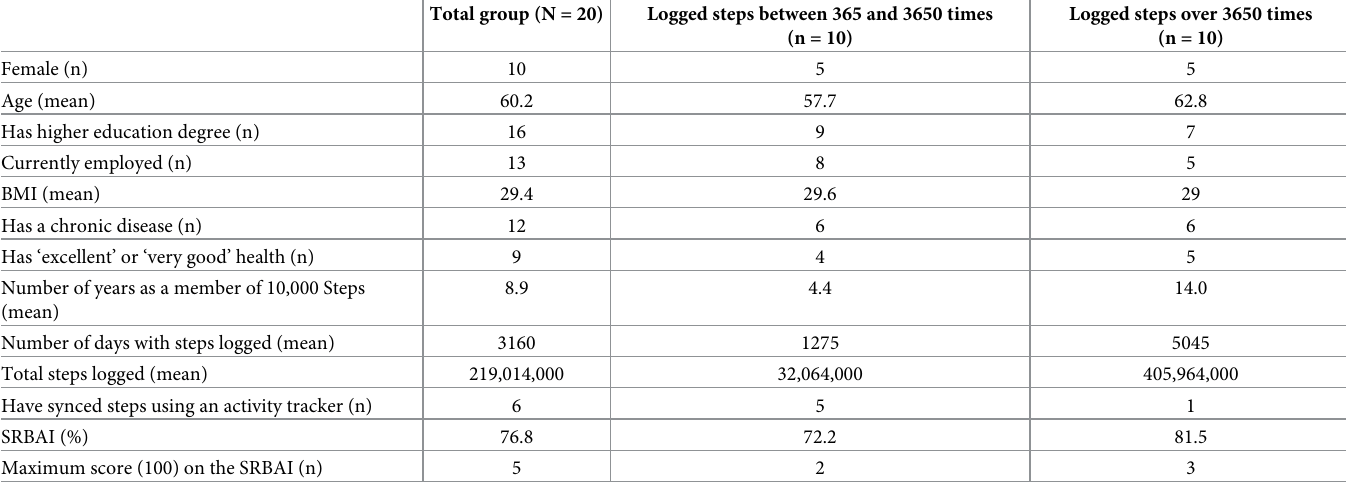
Table 2. Participant